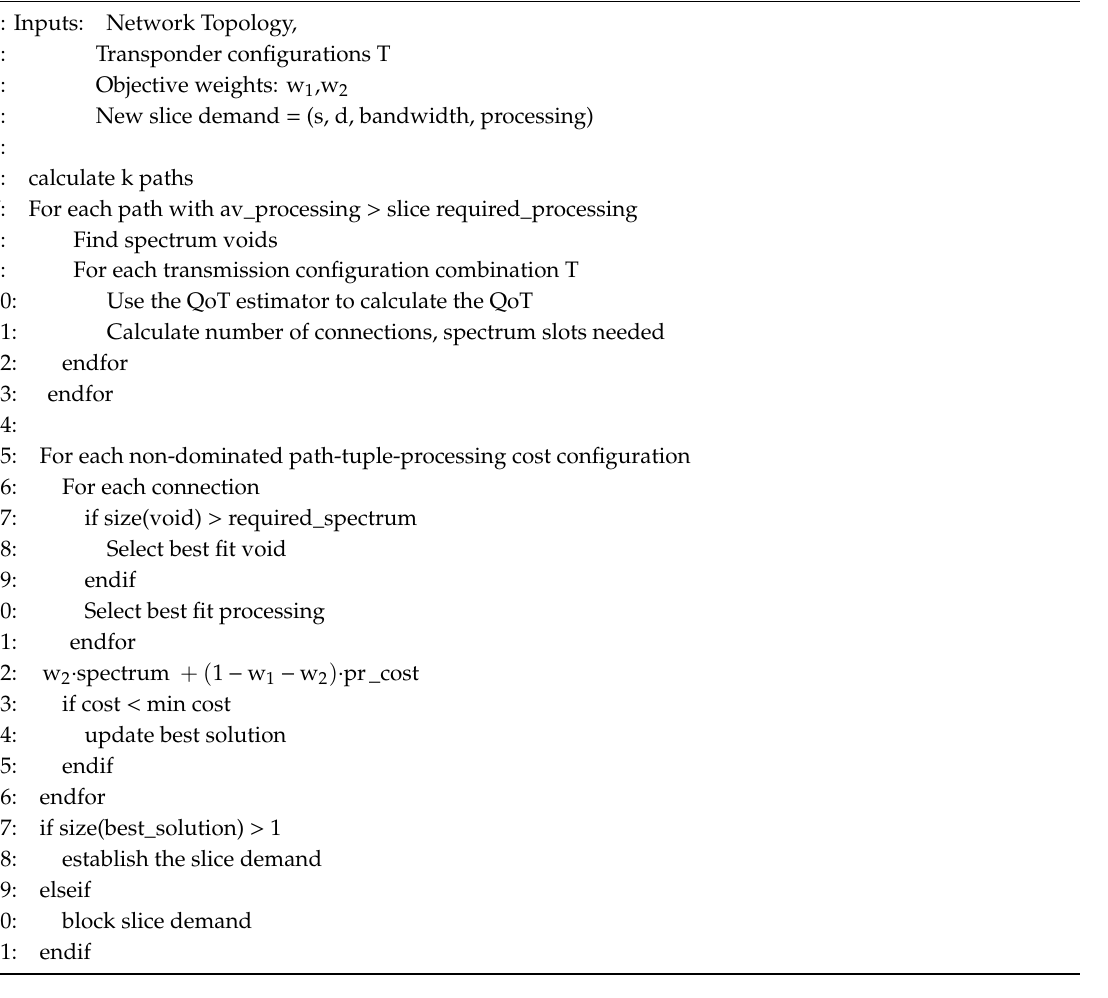
Algorithm 1 Pseudocode of the resource allocation heuristic